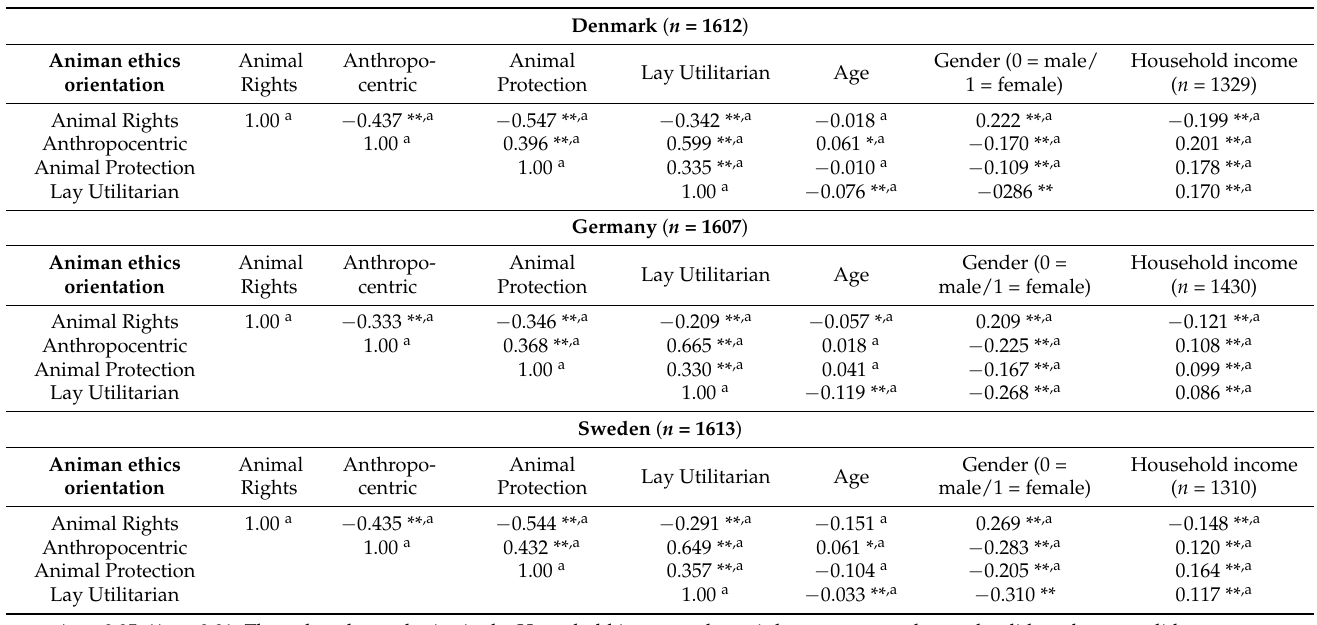
Table 3. Matrix of correlations between animal ethics orientations, age, gender, and household income reported separately for Denmark, Germany, and